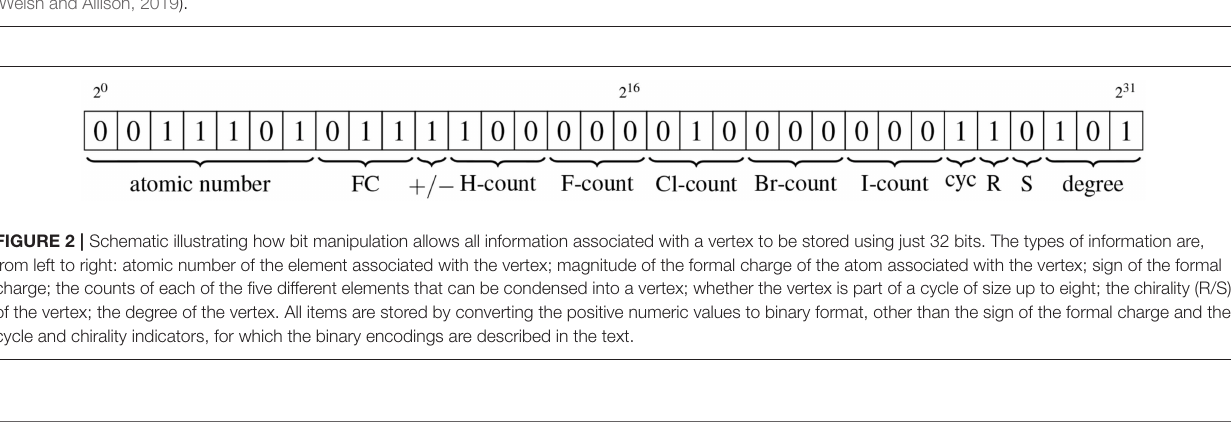
FIGURE 1 | Schematic of the process of automated parameterisation carried out by CherryPicker. The two red boxes indicate procedures described elsewhere (Welsh and Allison, 2019).